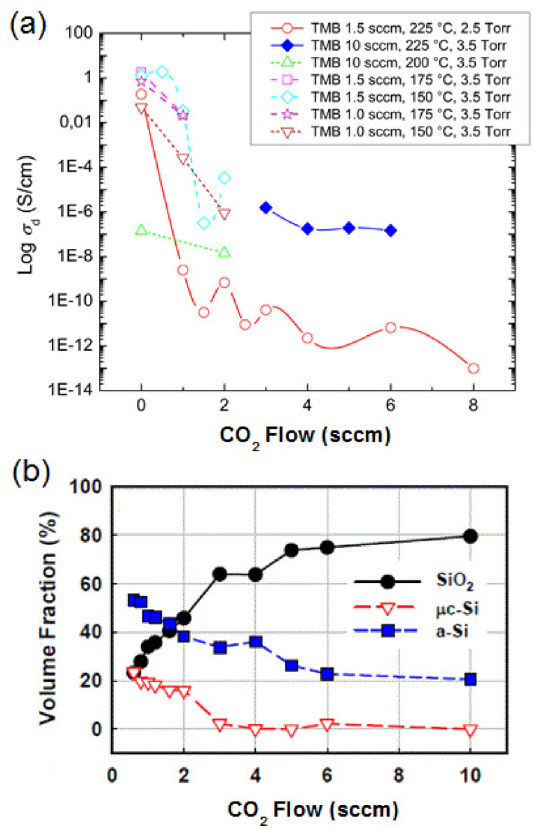
Fig. 2. (a) Dark conductivity (at room temperature) of p -type silicon oxide thin films as a function of CO 2 flow rate (the films were grown on Corning glass at H 2 (500 sccm)/SiH 4 (10 sccm) =50 and with 2% B(CH 3 ) 3 in H 2 ) and (b) evolution of SiO 2 , a -Si and μc -Si volume fractions of optimized μc -SiO:H p -layer with increasing CO 2 flow rate, as deduced from the BEMA